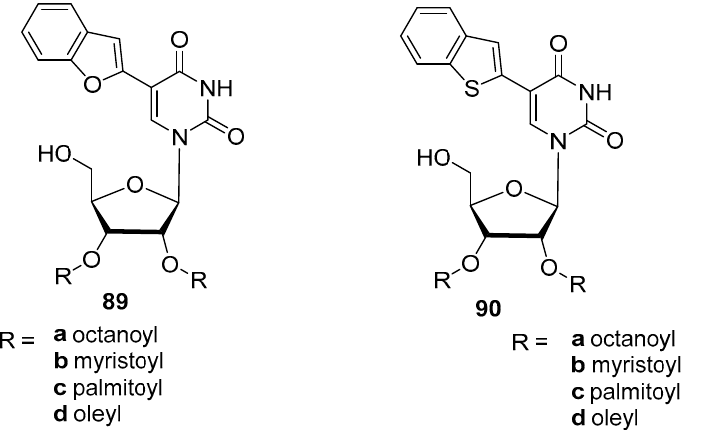
Figure 52. 5-Benzofuran and 5-benzothiophene based nucleolipid gelators derived from uracil [100].